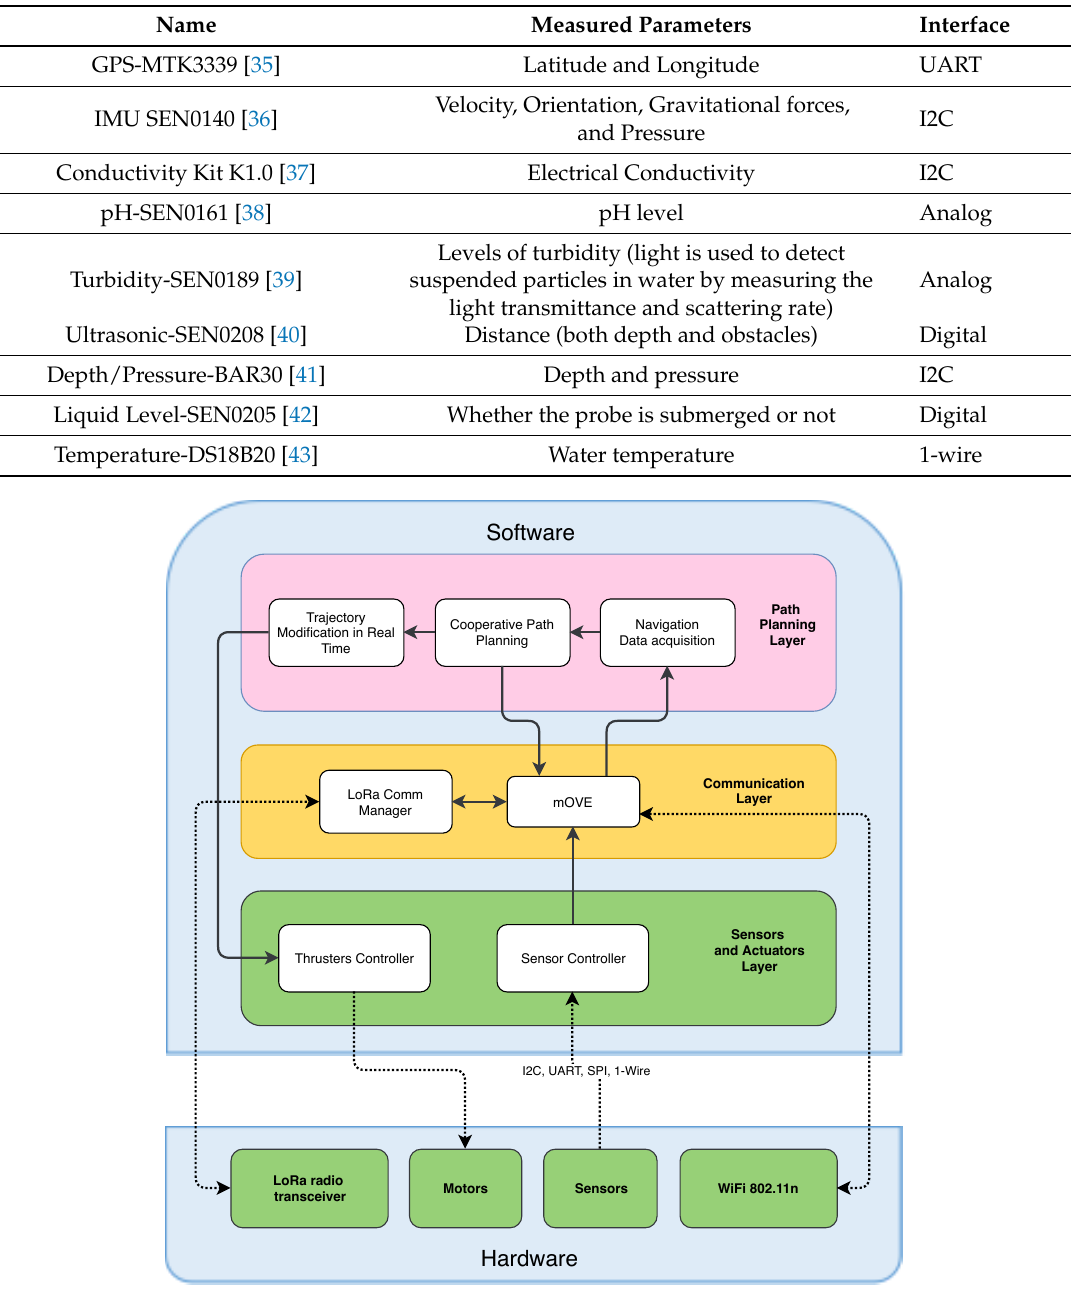
Table 3. Sensors description.